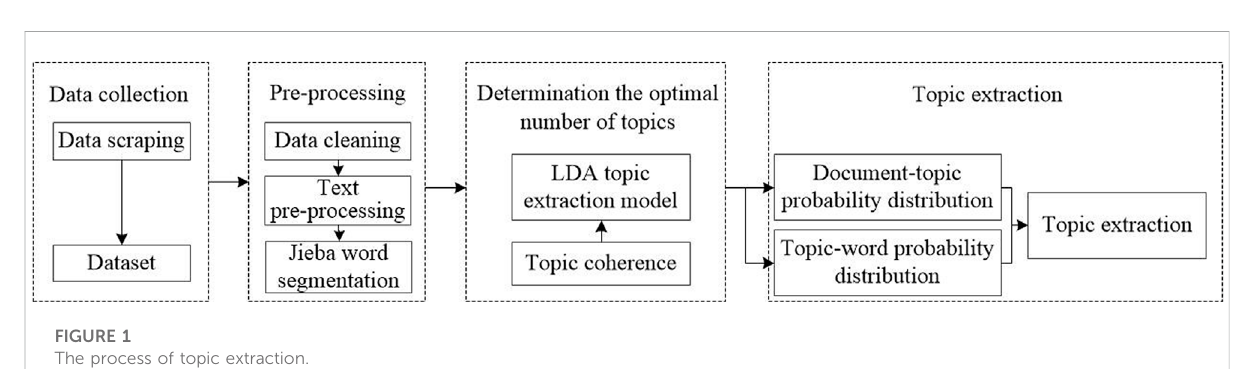
FIGURE 1 The process of topic